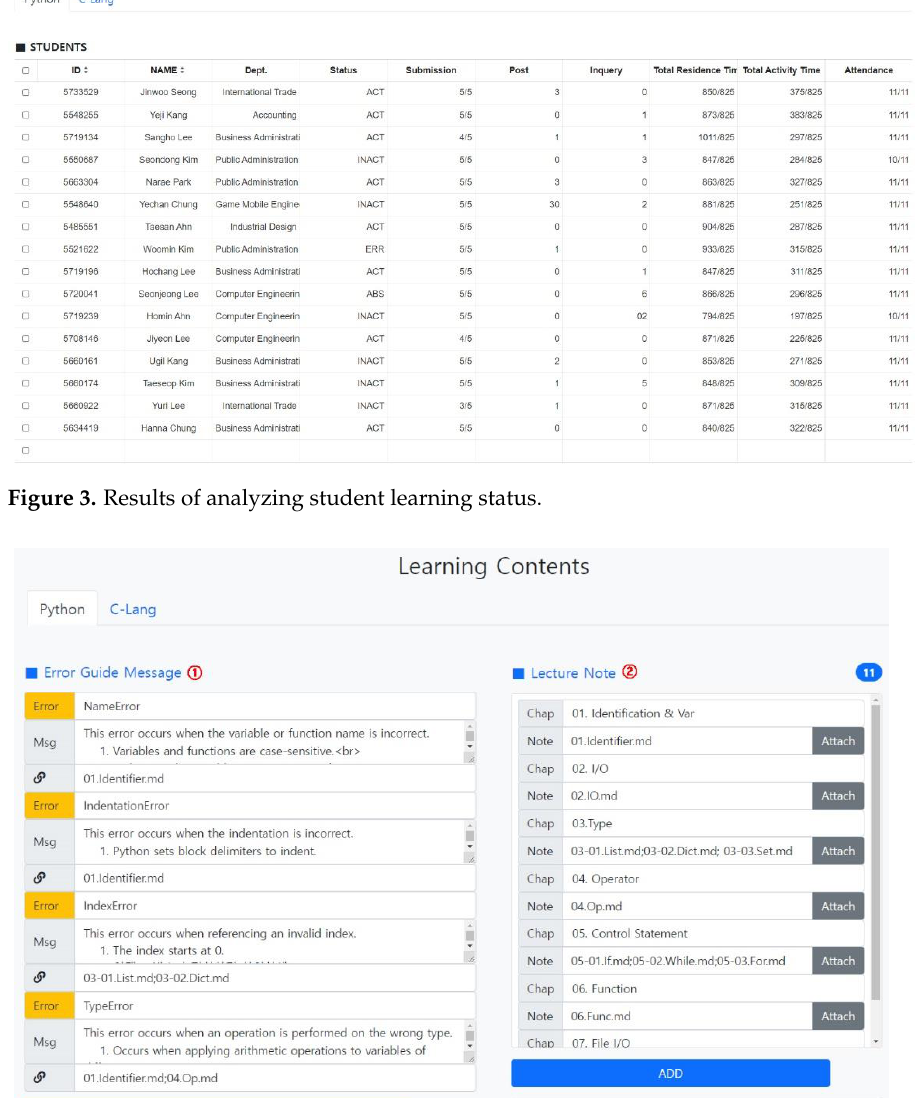
Figure 3. Results of analyzing student learning status.